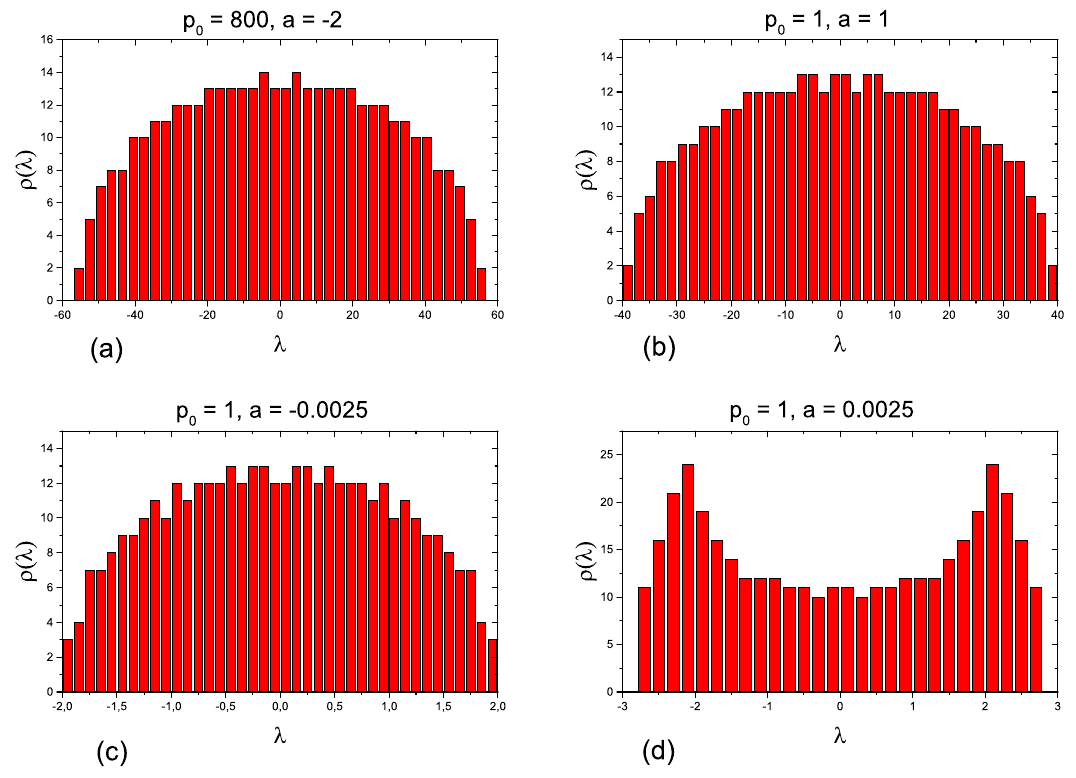
Figure 2 . Samples of transfer matrices spectral densities for trees of K = 400 generations and various cases: (a) p 0 = 800 ; a = (cid:0) 2; (b) p 0 = 1 ; a = 1; (c) p 0 = 1 ; a = (cid:0) 0 : 0025; (d) p 0 = 1 ; a = 0 :